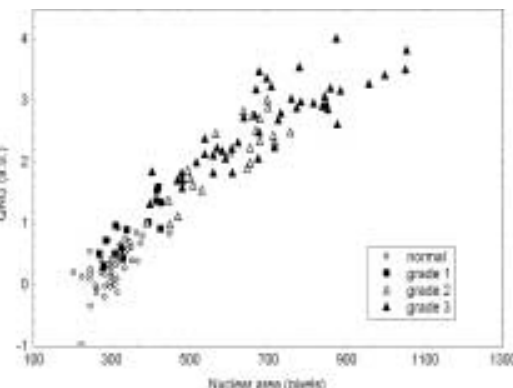
Fig. 2. Correlation of quantitative nuclear grade (QNG) with mean nuclear area.